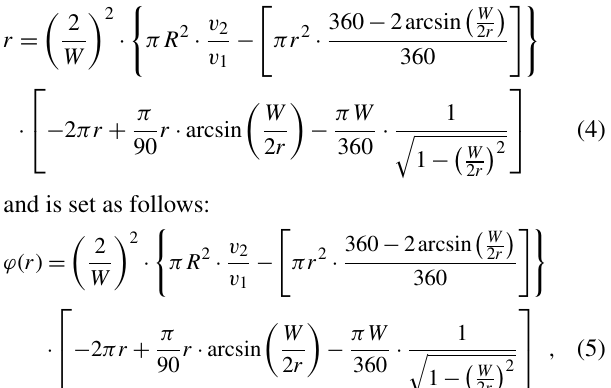
Figure 2. The solution steps of Newton